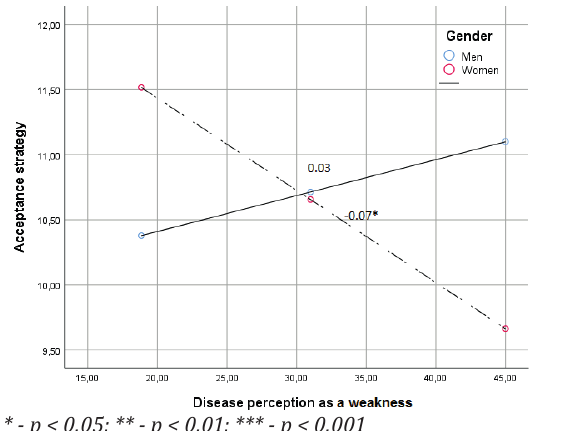
Figure 4. Interaction effect between disease perception as a weakness and gender on the frequency of acceptance as coping strategy for